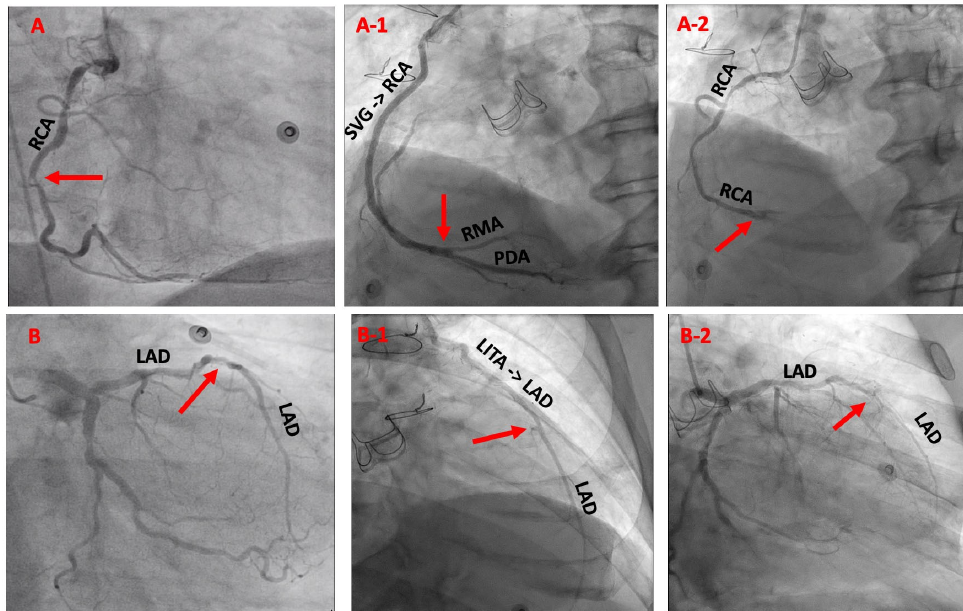
Figure 4. Chart bars showing the clinical status of surviving patients based on their NYHA class. Table 4. Long ‐ term clinical outcomes. Follow ‐ Up Results All Patients 326 (100) Single ‐ APT ( n = 152)